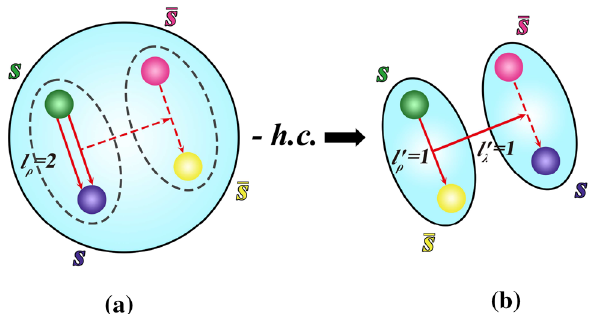
Fig. 2 Possible internal orbital angular momenta contained in the fully-strange tetraquark currents of J PC = 4 +− . The Fierz identity given in Eq. (6) indicates that the internal orbital angular momenta con- tained in the diquark–antidiquark system { l λ = 0, l ρ = 2 / 0, l ρ (cid:2) = 0 / 2 } correspond to those contained in the meson–meson system { l (cid:2) λ = 1, l (cid:2) ρ = 1, l (cid:2) ρ (cid:2) = 0